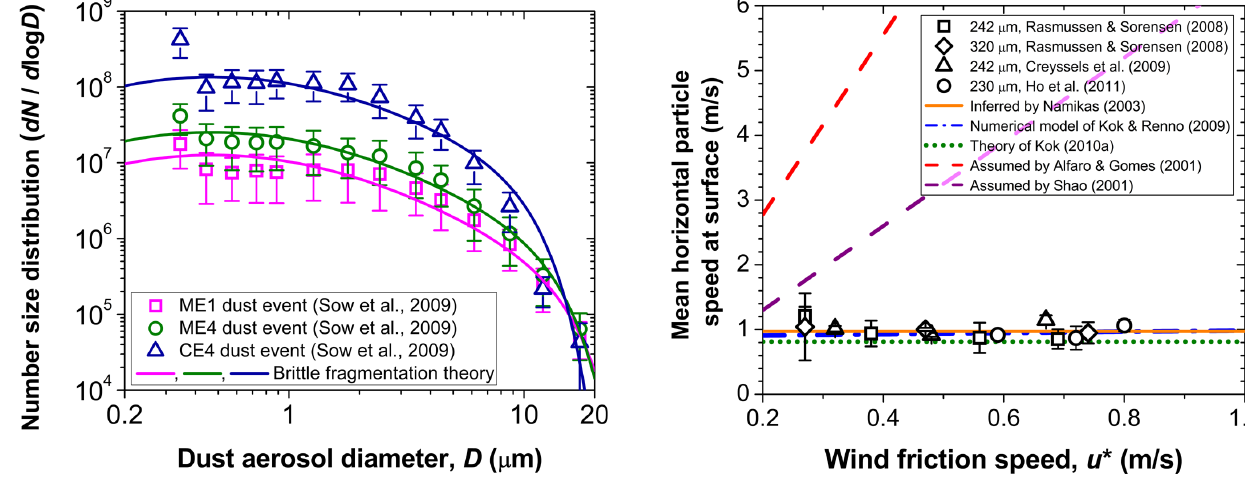
Fig. 4. Wind tunnel measurements of the speed of ∼ 250–300µm saltating particles (symbols) indicate that the mean horizontal speed at the surface stays constant with u ∗ . Similarly, Namikas (2003) in- ferred from his field measurements that the speed with which saltat- ing particles are launched from the surface is independent of u ∗ (solid orange line). These experimental results are supported by predictions for 250µm sand by both theory (dotted green line de- notes Eqs. (13) and (14) of Kok, 2010a; see also Ungar and Haff, 1987 and Duran et al., 2011) and a recent numerical model (dash- dotted blue line; Kok and Renno, 2009). The assumption of in- creasing saltator speed by Alfaro and Gomes (2001; dashed red line) and Shao (2001; dashed purple line) is thus likely incorrect. (The impact speed of v imp =20 u ∗ assumed by Alfaro and Gomes (see their Eq. 1) and the launch speed and angle of ∼ 0.70ms − 1 and ∼ 35 ◦ degrees inferred by Namikas (2003) were converted to a mean horizontal surface spseed by using that the rebound speed is ∼ v imp /2, and that the impact and launch angles are ∼ 12 ◦ and ∼ 35 ◦ degrees (Kok and Renno, 2009). The wind tunnel measure- ments of Rasmussen and Sorensen (2008), Creyssels et al. (2009), and Ho et al. (2011) were extrapolated to the surface as detailed in Kok